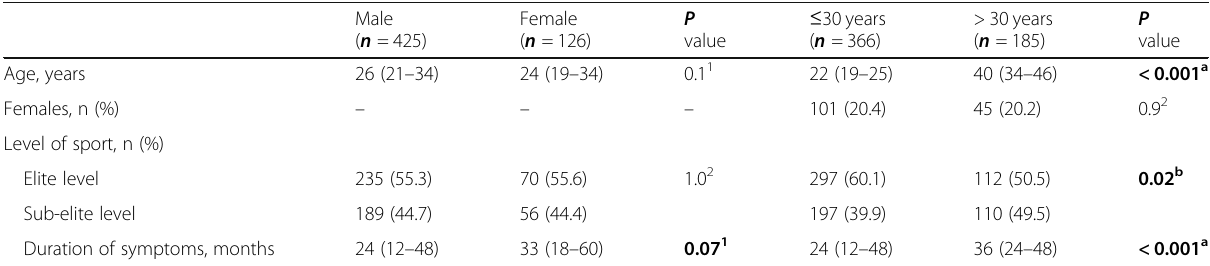
Table 2 Patient demographics and preoperative data between gender and the two ages groups,